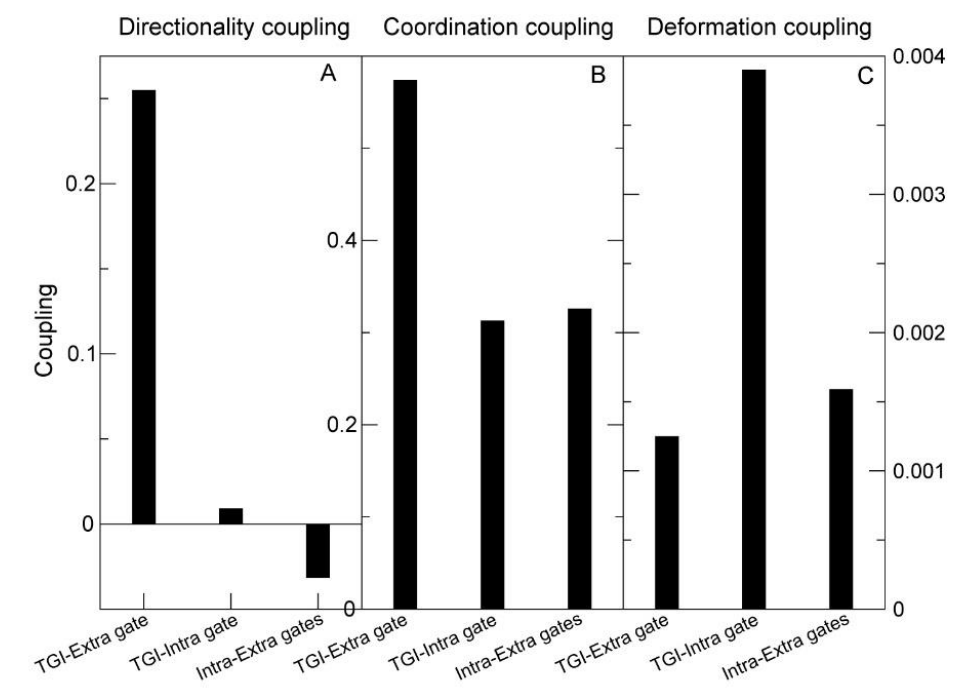
Figure 8. Directionality coupling ( A ), coordination coupling ( B ) and deformation coupling ( C ) be- tween three pairs of functional sites (horizontal axis): extracellular gate with tiagabine binding site (TGI) (first bar), intracellular gate with TGI (second bar) and intracellular gate with extracellular gate (third bar). The couplings are calculated with PDB:7sk2, which is an inward-open conformation in complex with the inhibitor tiagabine. Note that the TGI, which is thought to overlap the GABA binding site, is strongly co-directional and coordinated with the extracellular gate, but has low co- directionality and coordination with the intracellular gate. On the contrary, the TGI and the intra- cellular gate can strongly perturb each other ( C